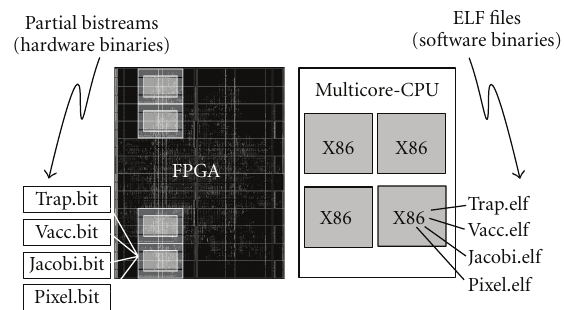
Figure 11: Mapping binaries to a generic template bitstream and X86 multicore